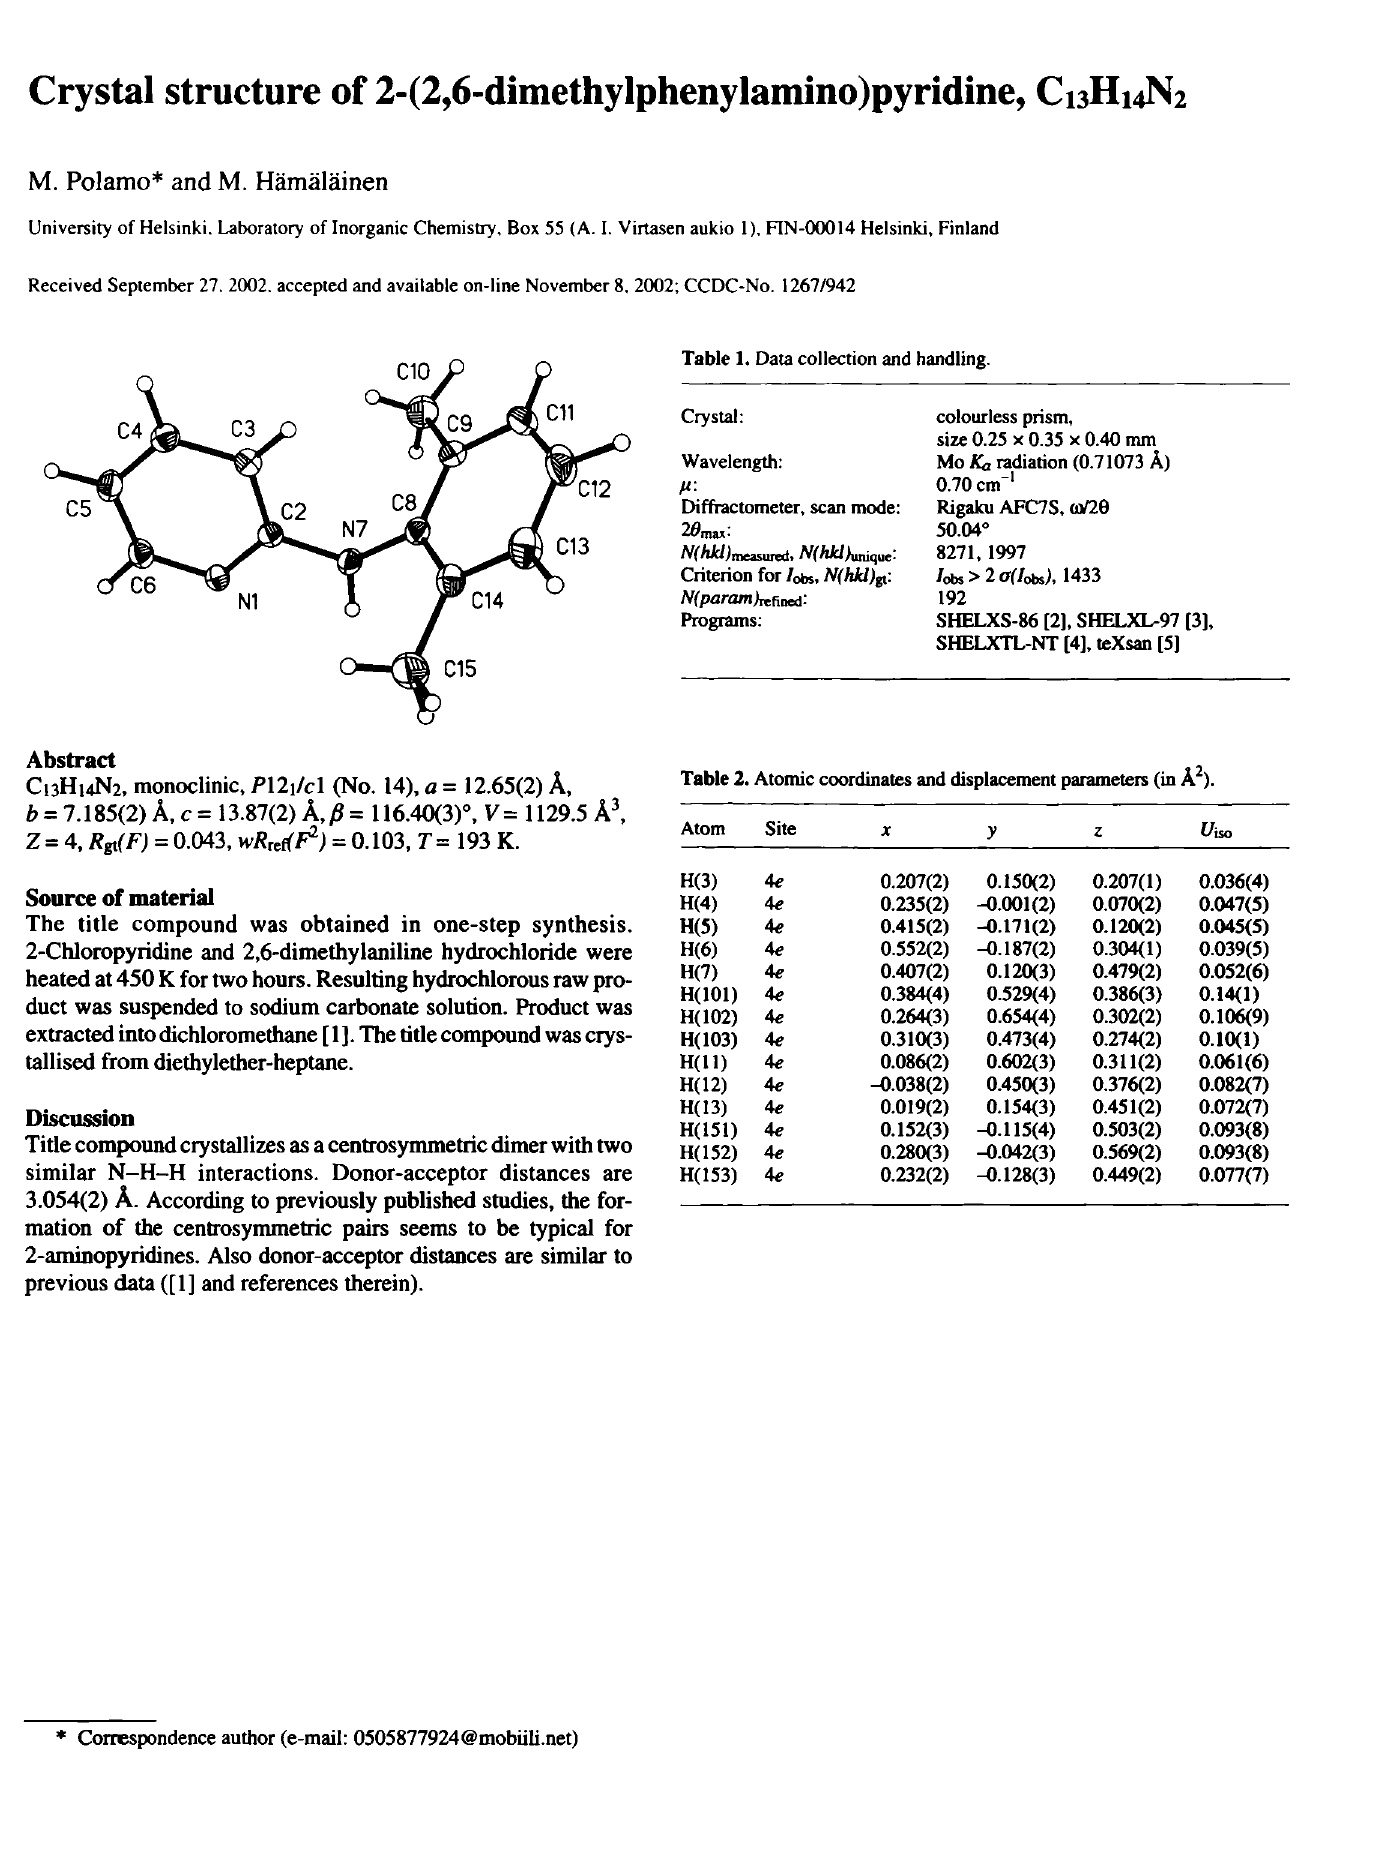
Table 1. Data collection and handling.